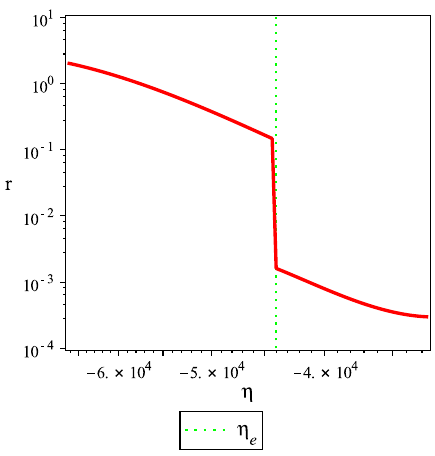
Fig. 5 The evolution of scalar and tensor perturbation versus η with (cid:13) = 0 . 08 for the case contained term H 4 . Dash blue line indicates the scalar perturbation evolution and solid red line indicates the tensor